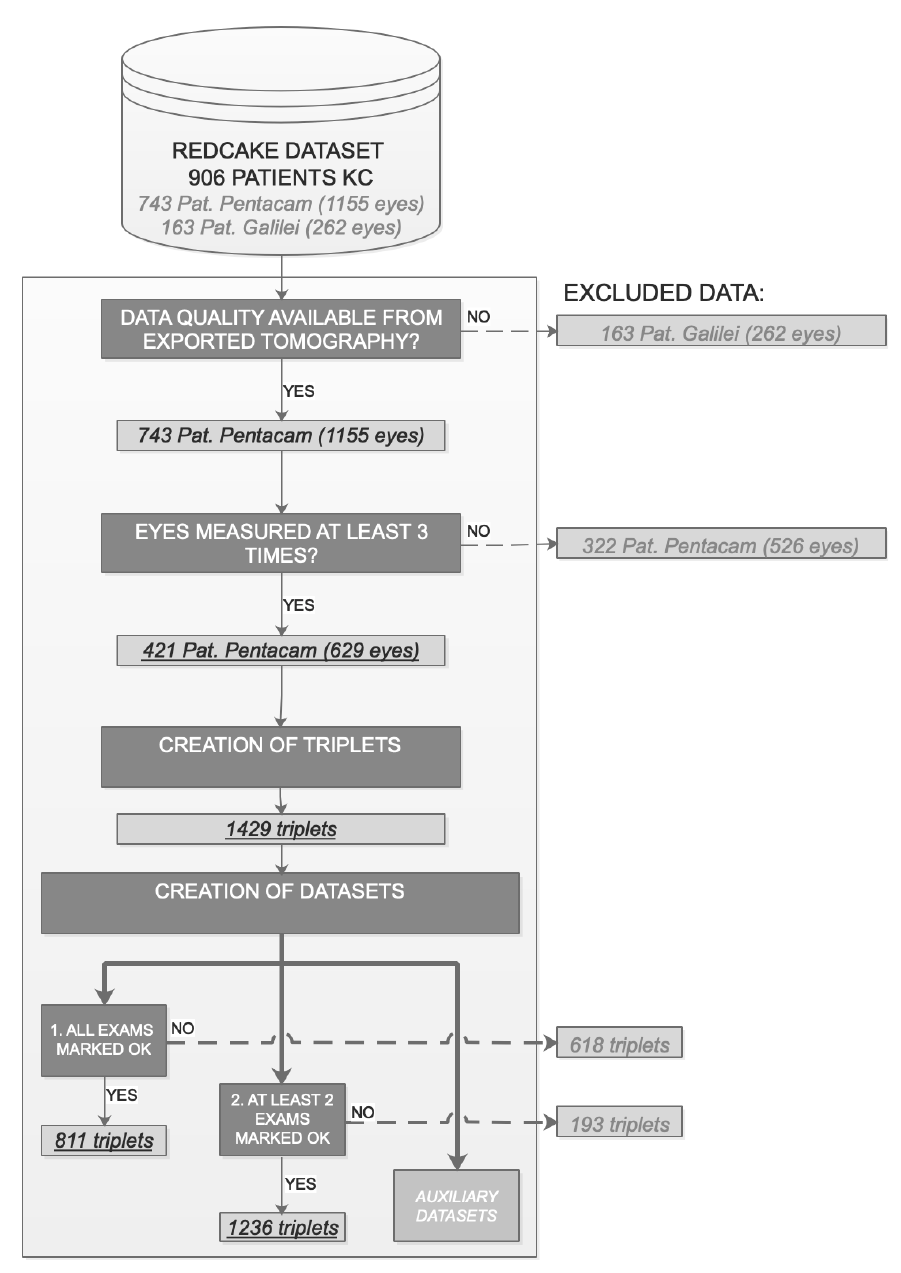
Figure 2. Data filtering. Creation of datasets. Final number of patients, eyes and triplets are highlighted in underlined italics.